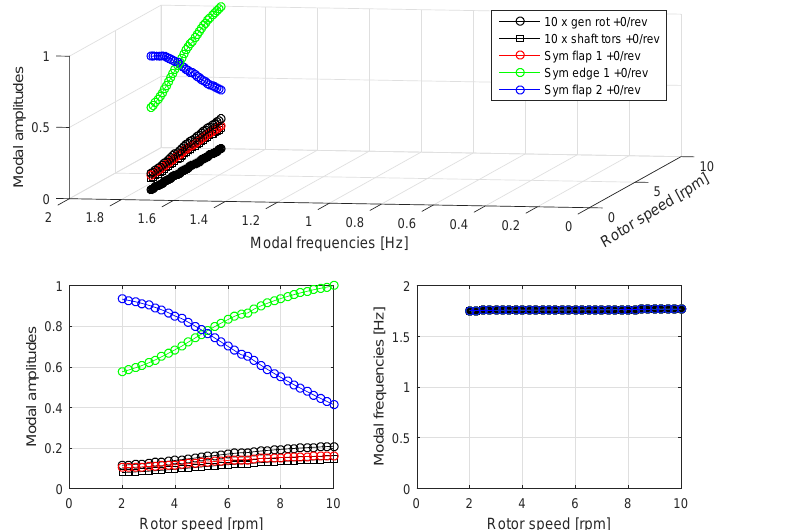
Figure 22. Harmonic modal components for the two-bladed turbine mode dominated by symmetric deflection of the rotor in the edgewise DOF for the higher rotor speeds. Plot layout as in Fig. 5.